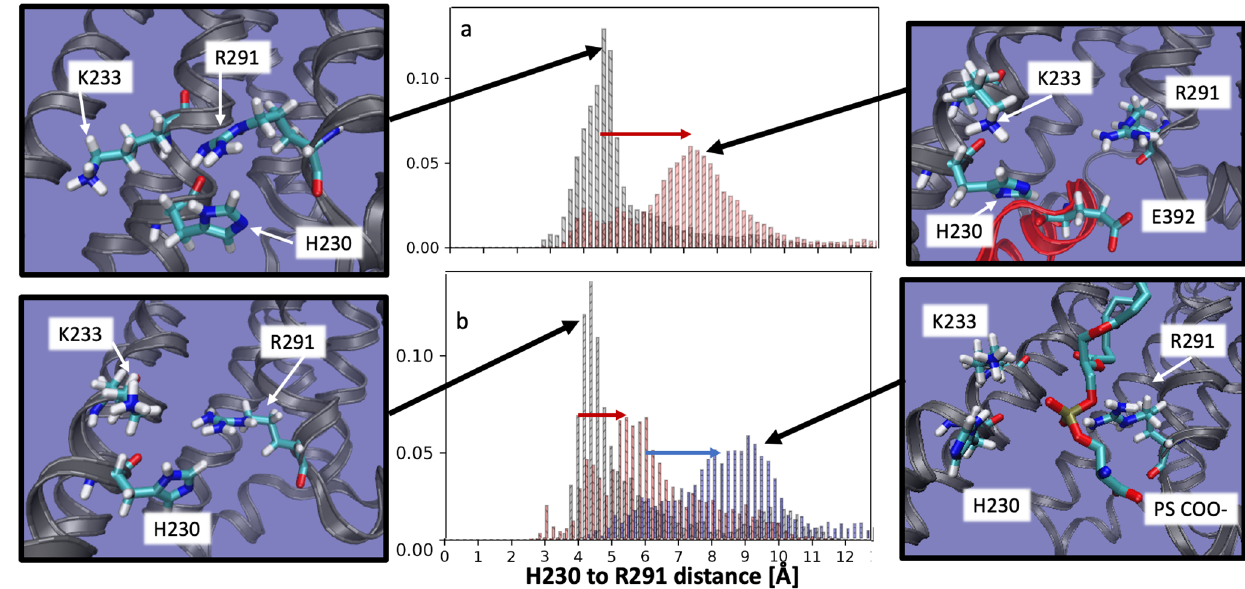
Fig. 5 | A 2A AR-lipid interactions observed in molecular dynamics simulations. Distance distribution between H230 6.32 and R291 7.56 shifts to farther distance (red arrow,panel ‘ a ’ )whenthereceptorswitchesfromtheinactivestate(panel ‘ a ’ ,black) to the fully active, G protein-coupled state (panel ‘ a ’ , red). When simulated in the fully active state but without the G-protein and no POPS (and with the backbone restrained to stay close to the fully active state), the H230 6.32 to R291 7.56 distance distribution (panel ‘ b ’ , black) is similar to the inactive state, but the shift to longer distances is partially recapitulated (red arrow, panel ‘ b ’ ) when simulated in a membrane containing 85%phosphatidylserine(panel ‘ b ’ , red).Upon releaseofthe